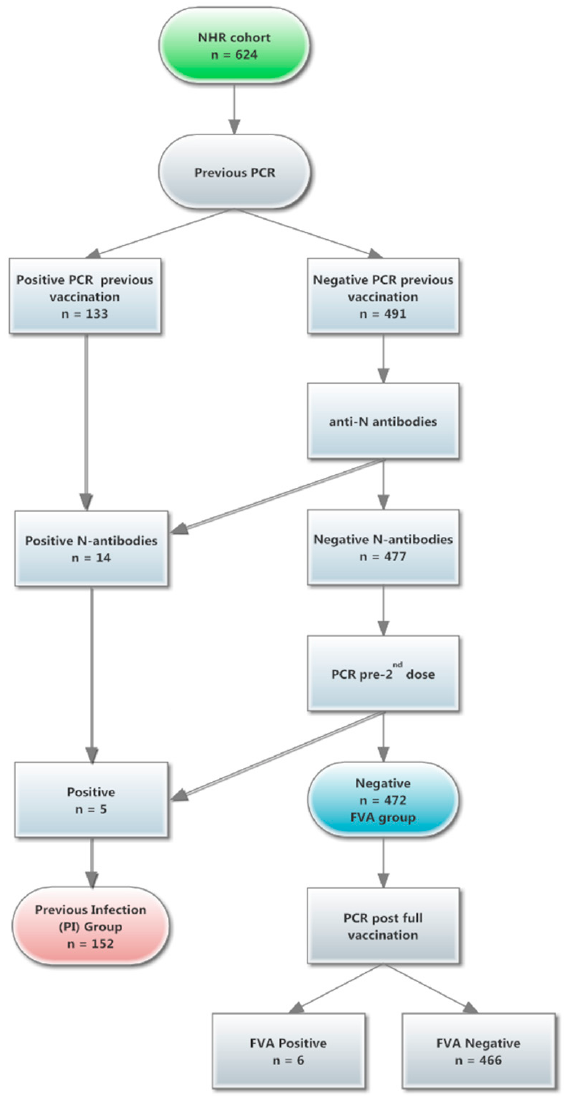
Figure 1. Study design. A total of 624 nursing home residents (NHR) were eligible for the study. Two different groups were defined: previous infection (PI) and full vaccination assessment (FVA).